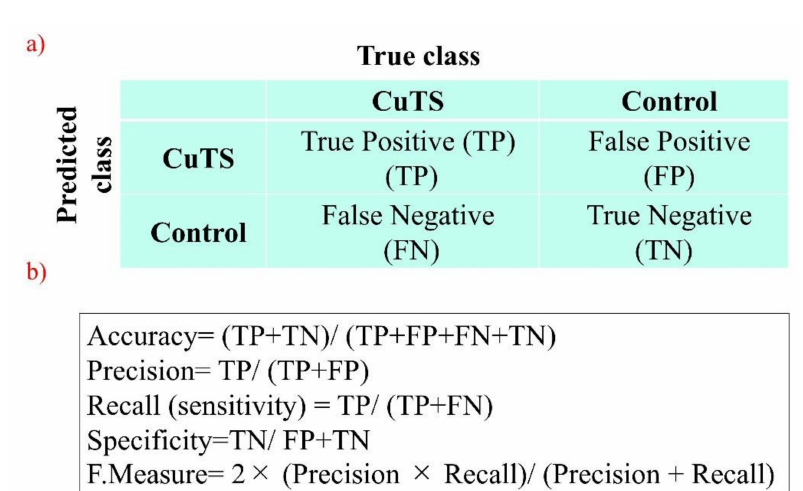
Figure 7. ( a ) A confusion matrix is a table of four combinations based on predicted and actual values and the presence or absence of disease; ( b ) diagnostic accuracy from the learning model is calculated from the confusion matrix created using testing